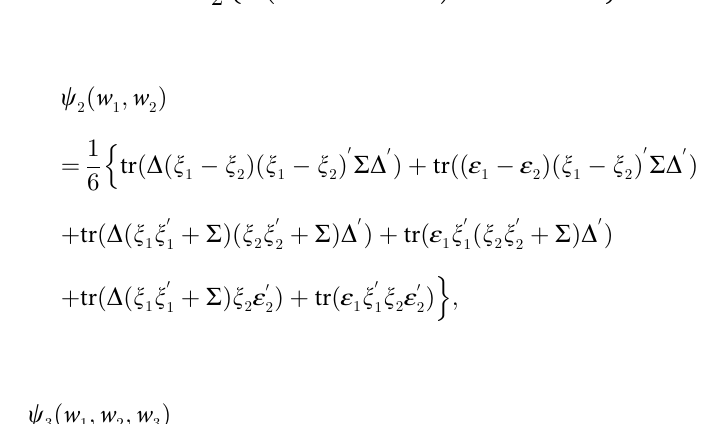
ffiffiffiffiffiffiffiffiffiffiffiffiffiffiffiffiffiffiffiffiffiffiffiffiffiffi tr ð M